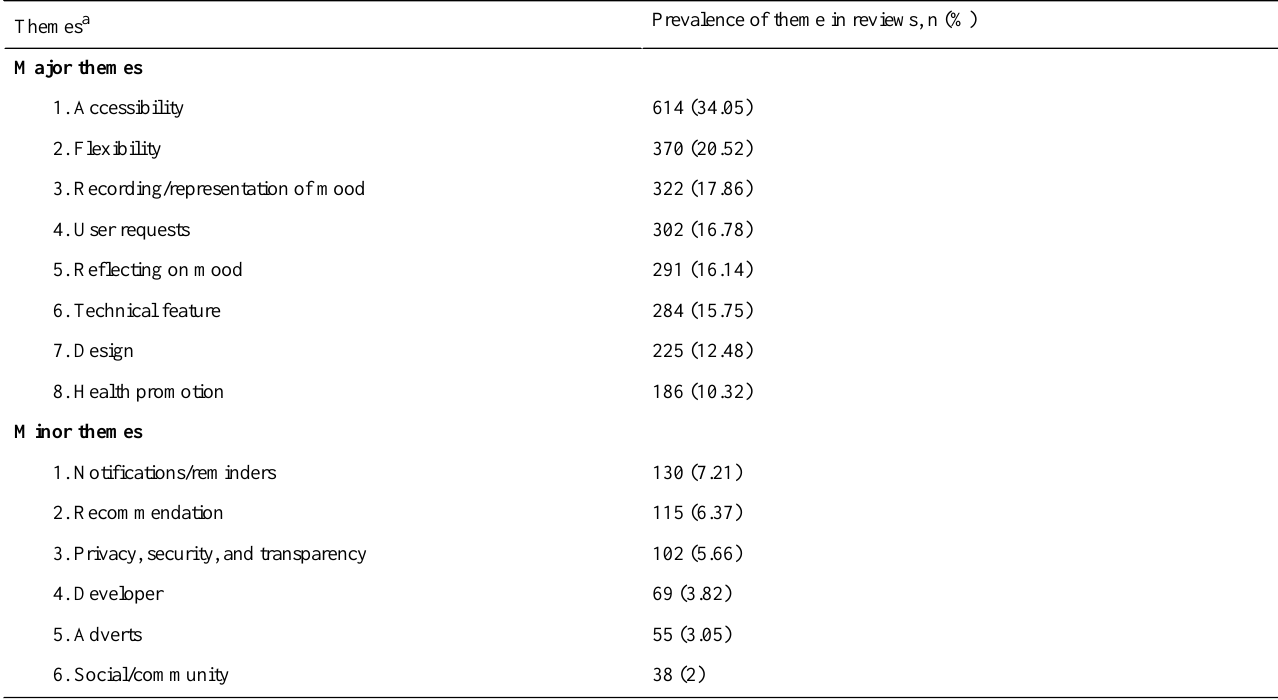
Table 1. Prevalence of major and minor themes identified in user reviews (N=1803, categories not